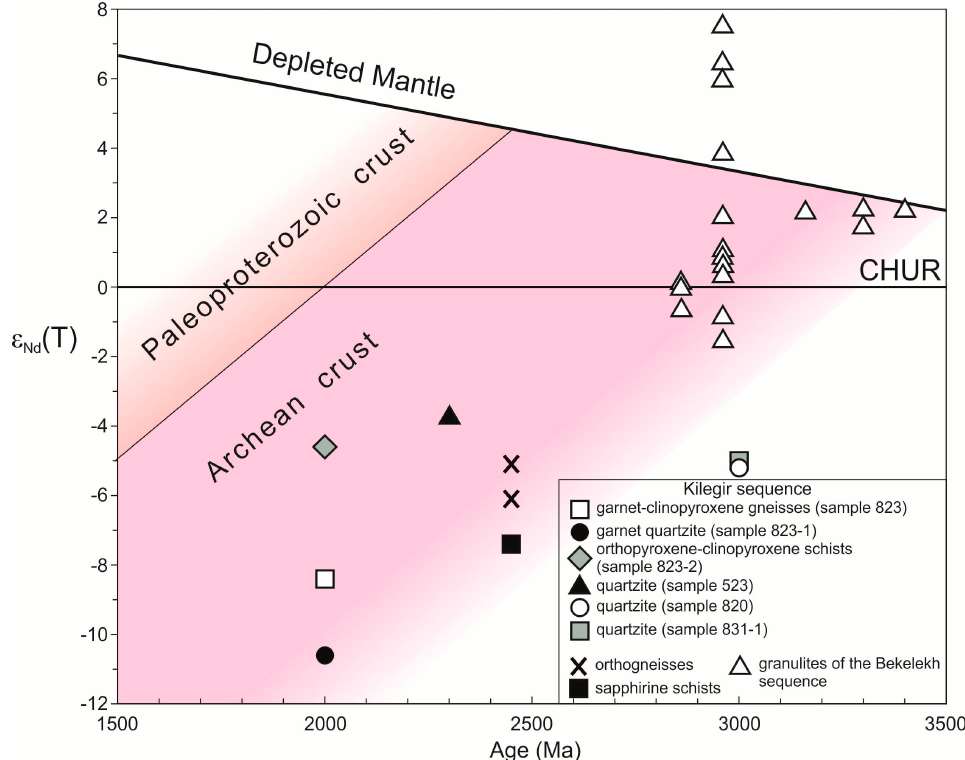
Figure 11. ε Nd versus age diagram for granulites of the Daldyn Group. Additionally, orthogneisses and sapphirine schists of the Kilegir sequence [30] and granulites of the Bekelekh sequence of the Daldyn Group are shown [7].